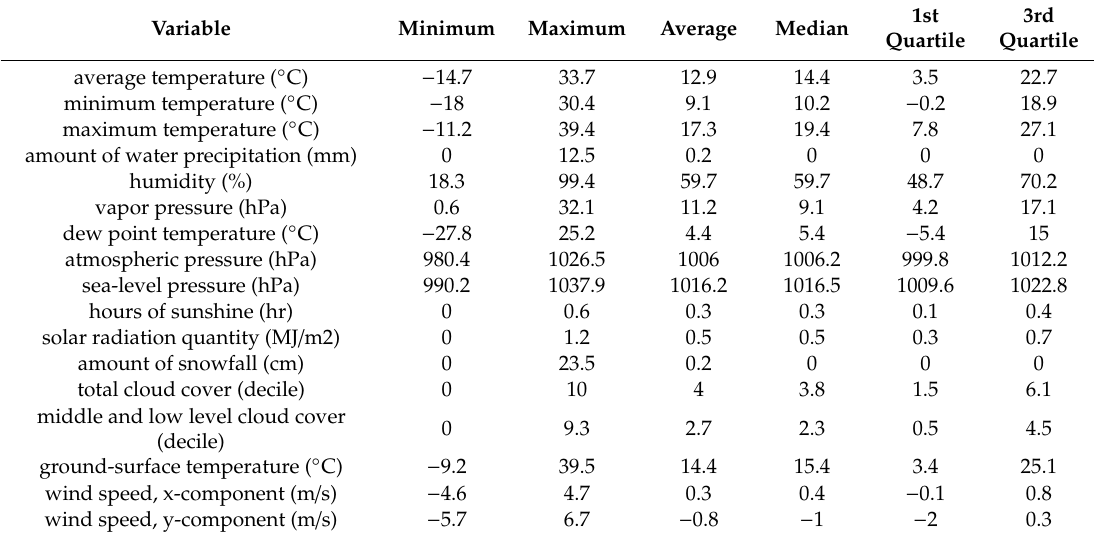
Table 11. Basic statistics for daily data in metropolitan area (Seoul).